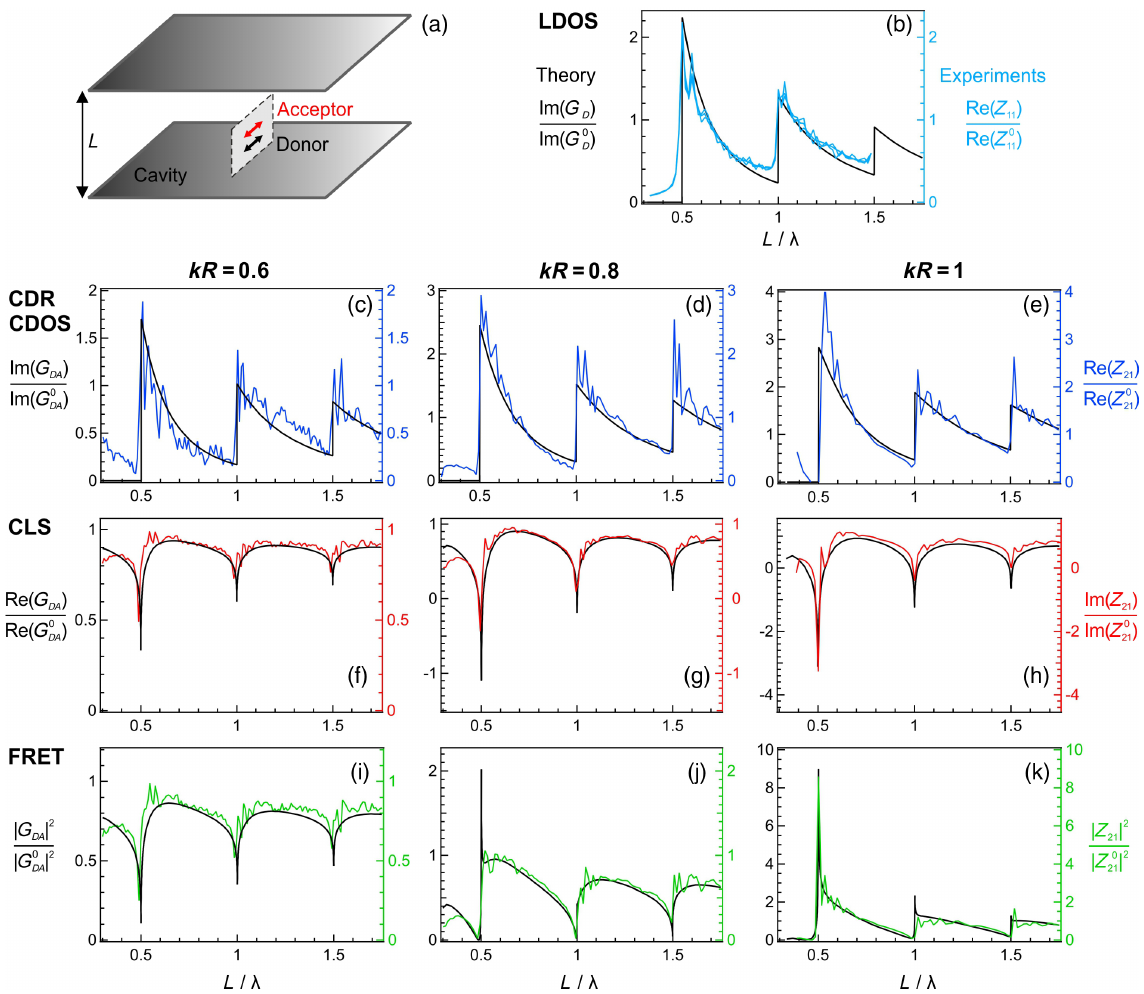
FIG. 2. Complex-valued Green function in a planar cavity compared to that in vacuum. (a) Configuration under study: the source donor dipole is located at 10 mm from the nearest mirror and is parallel to the mirror plane. The acceptor dipole is parallel to the donor dipole at R ¼ 10 mm distance. The frequency varies between 2.5 and 5.25 GHz. (b) Measured LDOS enhancement versus cavity length L at 5 GHz. The thin colored curves are measurements of the impedance Z 11 , whereas the thick black curve is the analytical prediction. (c) – (e) CDR or CDOS enhancement over vacuum versus cavity length for different kR values (indicated on top). The colored thin curves indicate measurements, whereas the thick black curves are the analytic results. (f) – (h) CLS enhancement, i.e., enhancement of the real part, over vacuum. (i) – (k) FRET enhancement, i.e., enhancement of the square modulus, over vacuum. These measurements provide a complete characterization of the complex Green function in a planar